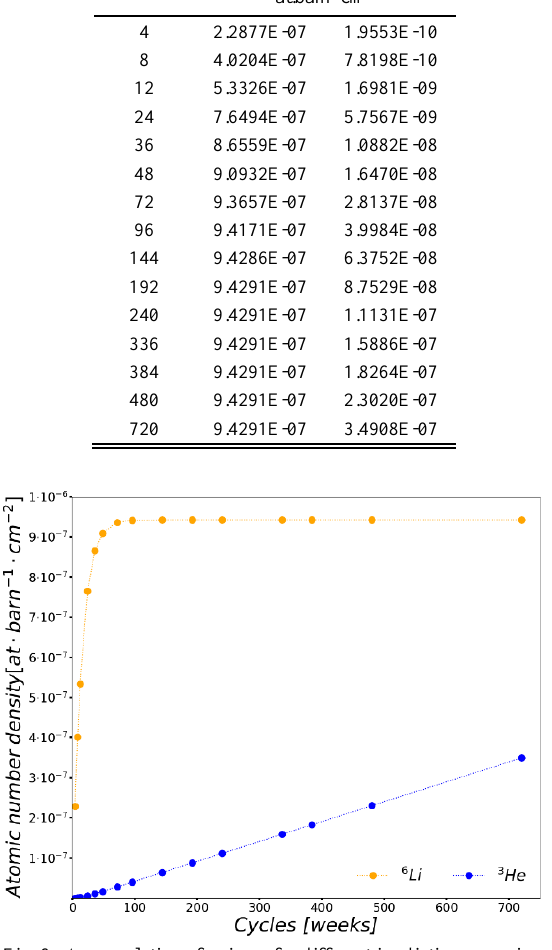
Fig. 6 - Accumulation of poisons for different irradiation scenarios .